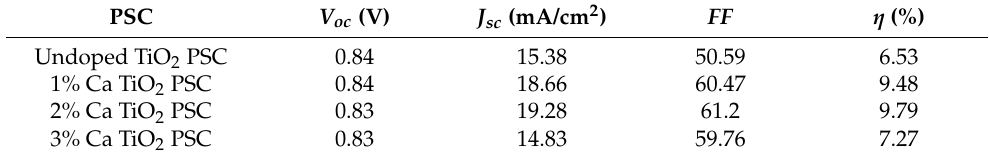
Table 4. PSCS electrical measurements J–V.